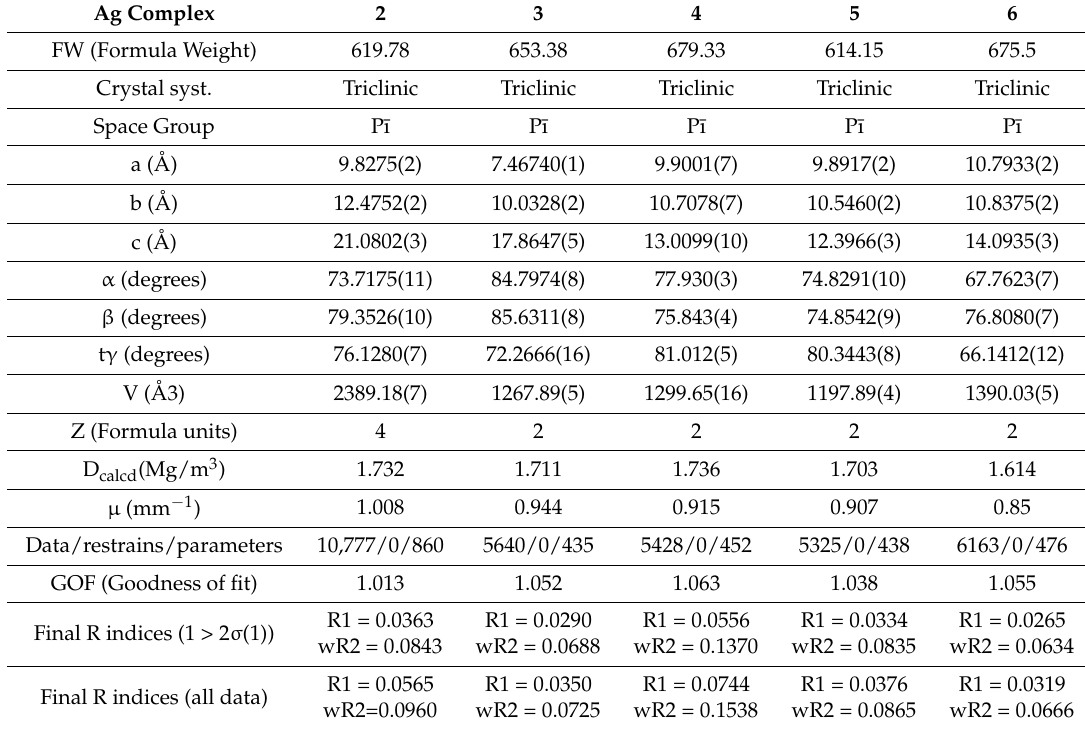
Table 1. Crystallographic data for Ag complexes 2 – 6 .